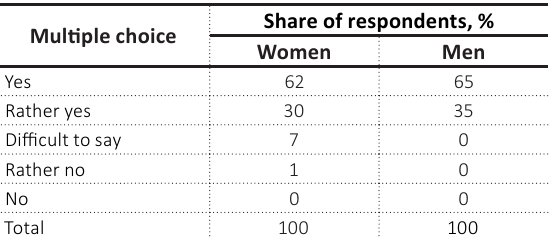
Table 4. The respondents’ answers